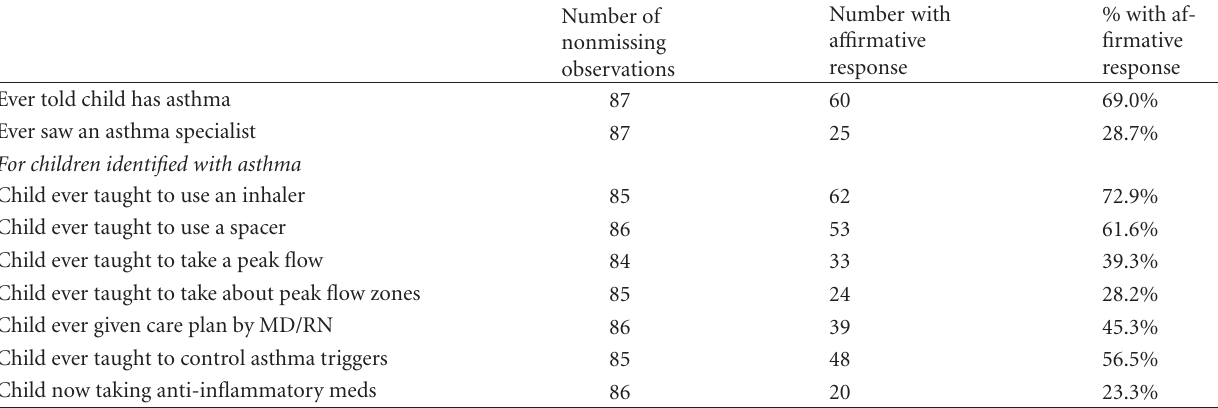
Table 2: Quality of care and patient